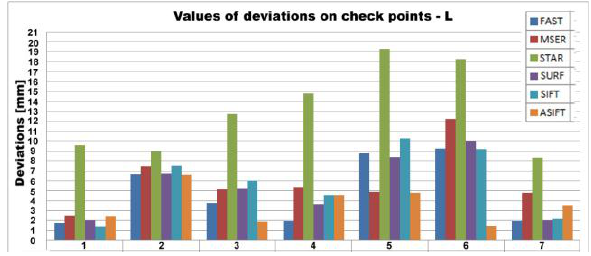
Figure. 7 Distribution of values of linear errors on signalled control points, X axis – point number, Y axis – deviations in mm.